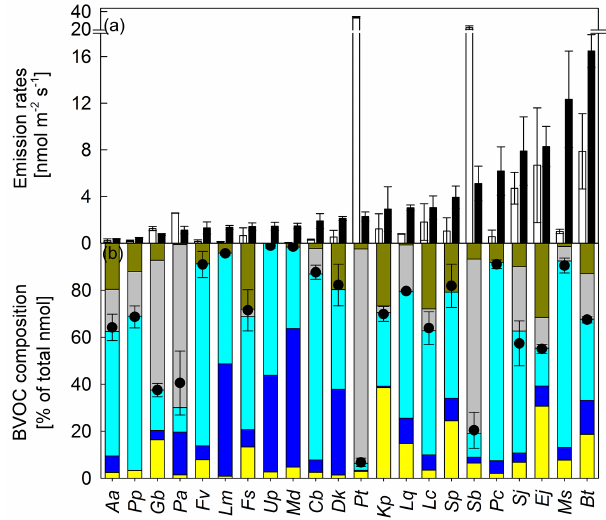
Figure 4. (a) BVOC emission rates and (b) composition of 22 broadleaf plant species sorted from low (left) to high (right) stress-induced BVOC emitters. Abbreviations are given in Table 1. Color code: (a) white cBVOCs; black sBVOCs(sBVOCs = BZs + GLVs + SQTs); (b) gray isoprene; green monoterpenes (MTs); yellow benzenoids (BZs); cyan green leaf volatiles (GLVs); blue sesquiterpenes (SQTs). Black points in- dicate the percentage of sBVOCs over the total BVOCs. The means of three plants ± SE are